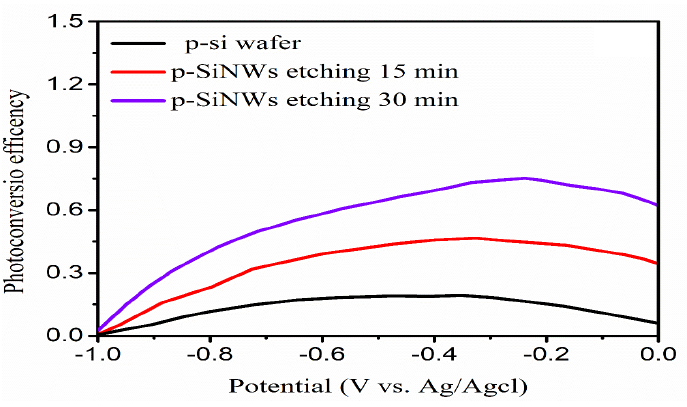
Figure 4: Photoconversion efficiency (ƞ) as a function of potential for Si (100) wafer, and SiNWs prepared using 15min and 30min of etching